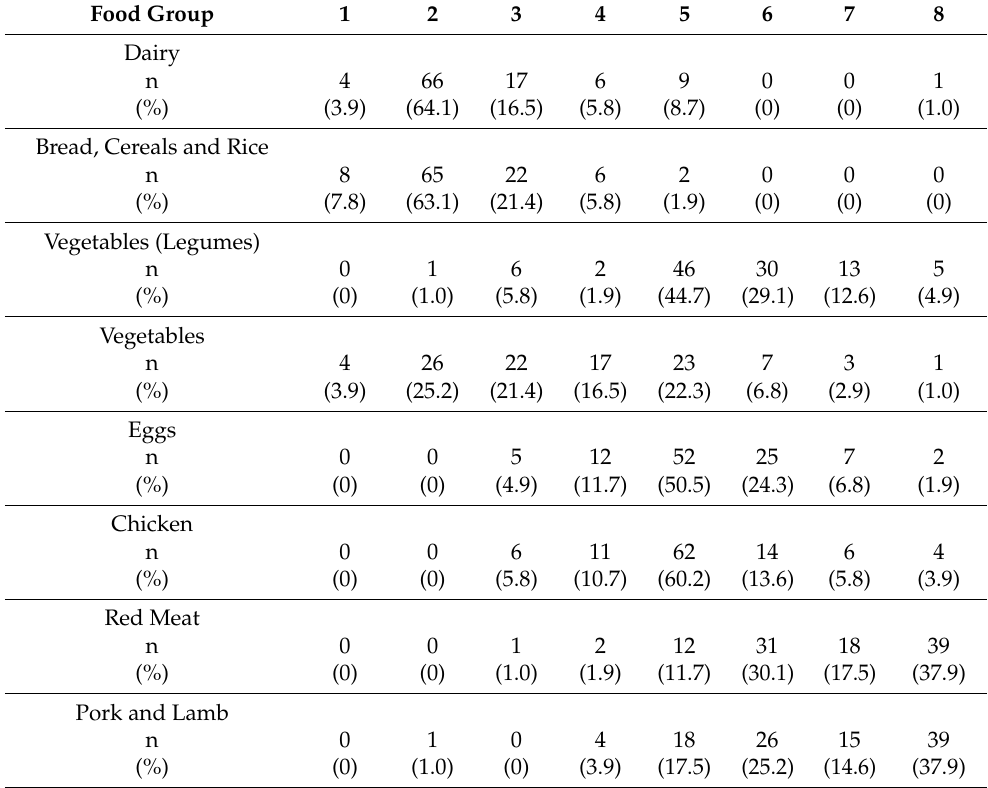
Table 3. Frequency of consumption of certain food groups in pregnant women. 1: 4–6